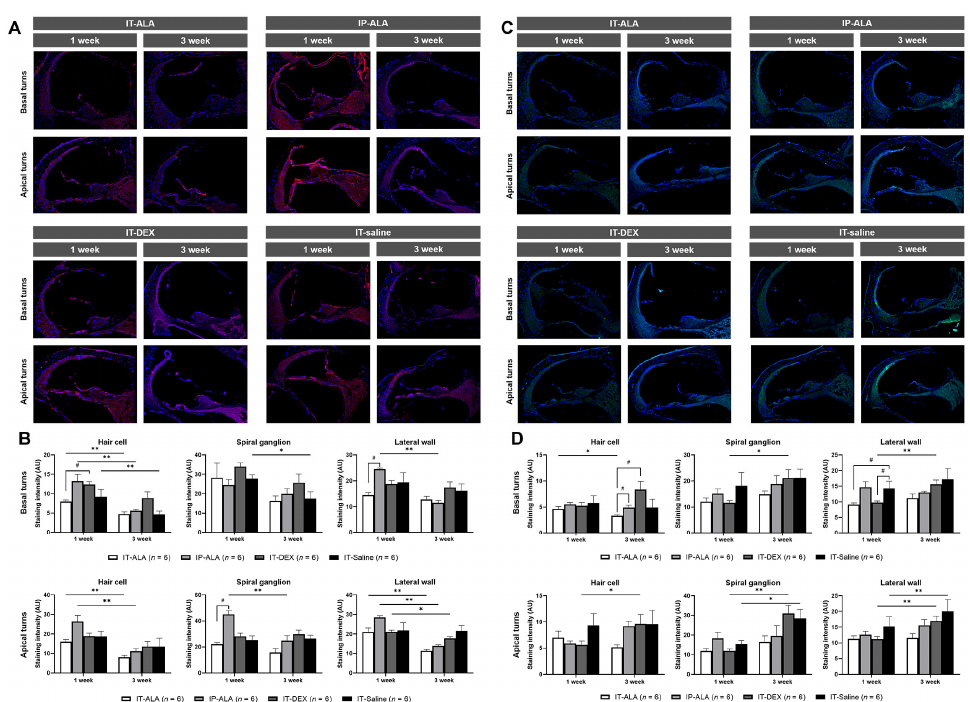
Figure 6. The expression of inflammatory markers in the mouse model of NIHL. A and B. Representative IL ‐ 1ß immunofluorescence findings ( A ) and quantitative analysis ( B ) showed IL ‐ 1ß expression was decreased in the IT ‐ ALA group compared with the IP ‐ ALA and IT ‐ DEX groups 1 week after drug administration. Significant difference was not observed among the groups 3 weeks after drug administration. ( C , D ) Immunofluorescence results showed NF ‐κ B expression was significantly decreased in the IT ‐ ALA group. In addition, NF ‐κ B expression was significantly increased in the IT ‐ DEX and IT ‐ saline groups 3 weeks after injection; however, the change was non ‐ significant and even decreased in the IT ‐ ALA group. IT, intratympanic; ALA, ɑ ‐ lipoic acid; DEX, dexamethasone; NIHL, noise ‐ induced hearing loss.* Wilcoxon signed rank test, * p < 0.05, ** p < 0.01; # Mann–Whitney test with Bonferroni corrections, p < 0.05.